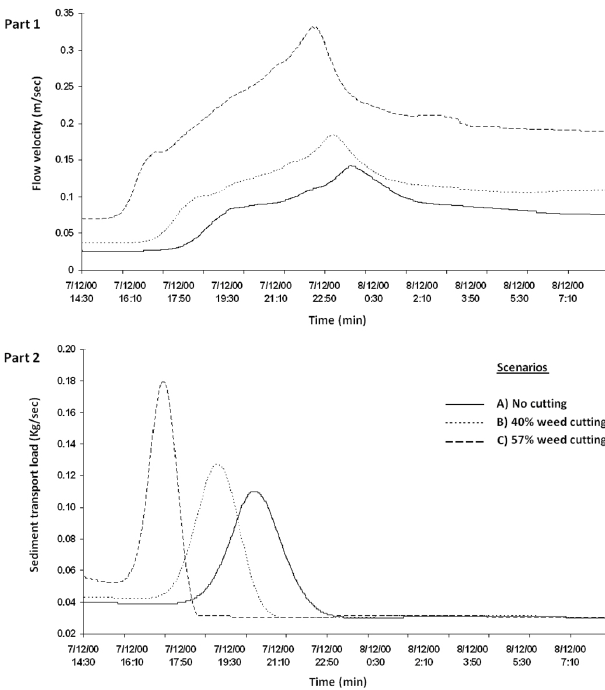
Fig. 3. Flow velocity and sediment transport load for different weed- cutting scenarios.